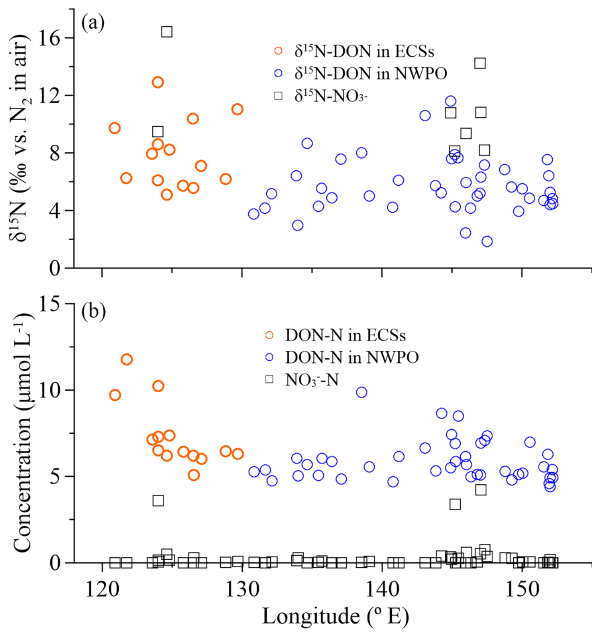
Figure 6. (a) δ 15 N-DON (open circles) and δ 15 N-NO − squares), and (b) concentrations of DON (open circles) and NO − (black squares) in SSW with longitude during the 2015